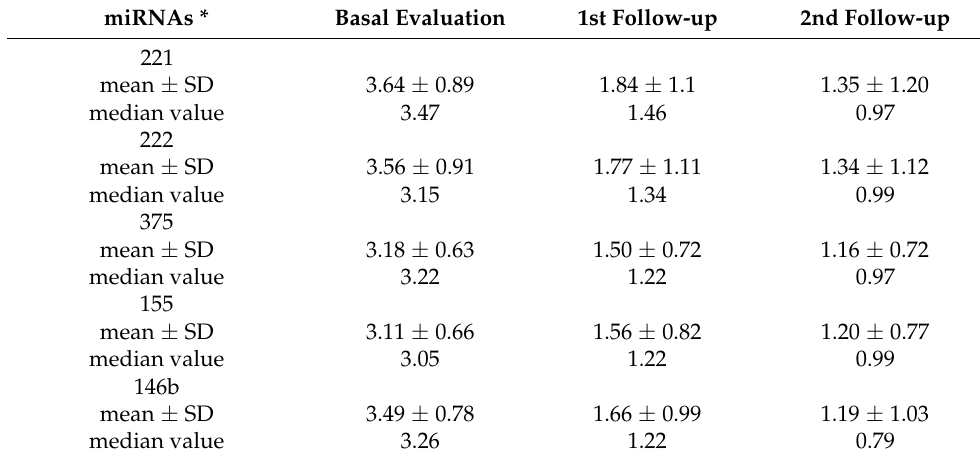
Table 2. Serum miRNAs expression in our PTC patients at different time